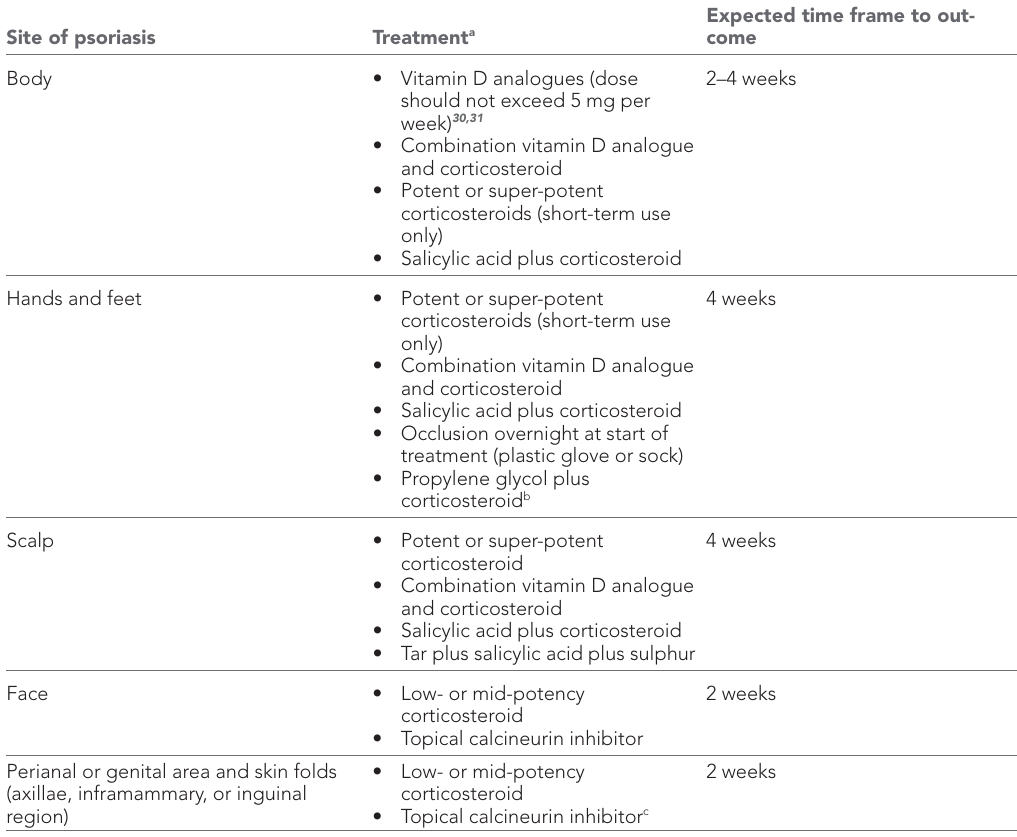
Table 4 Appropriate topical treatments for psoriasis by site and expected time to treatment out-